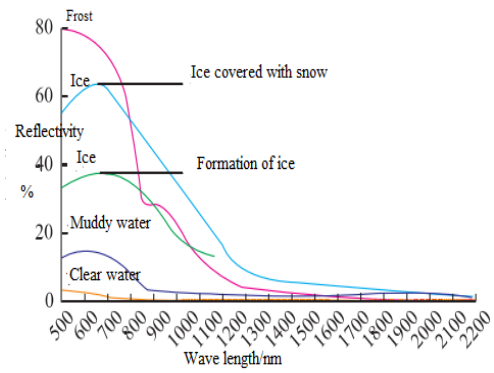
Fig. 2. Comparison of spectral features of snow, sea ice and sea water. From the literature (Ding Dewen,